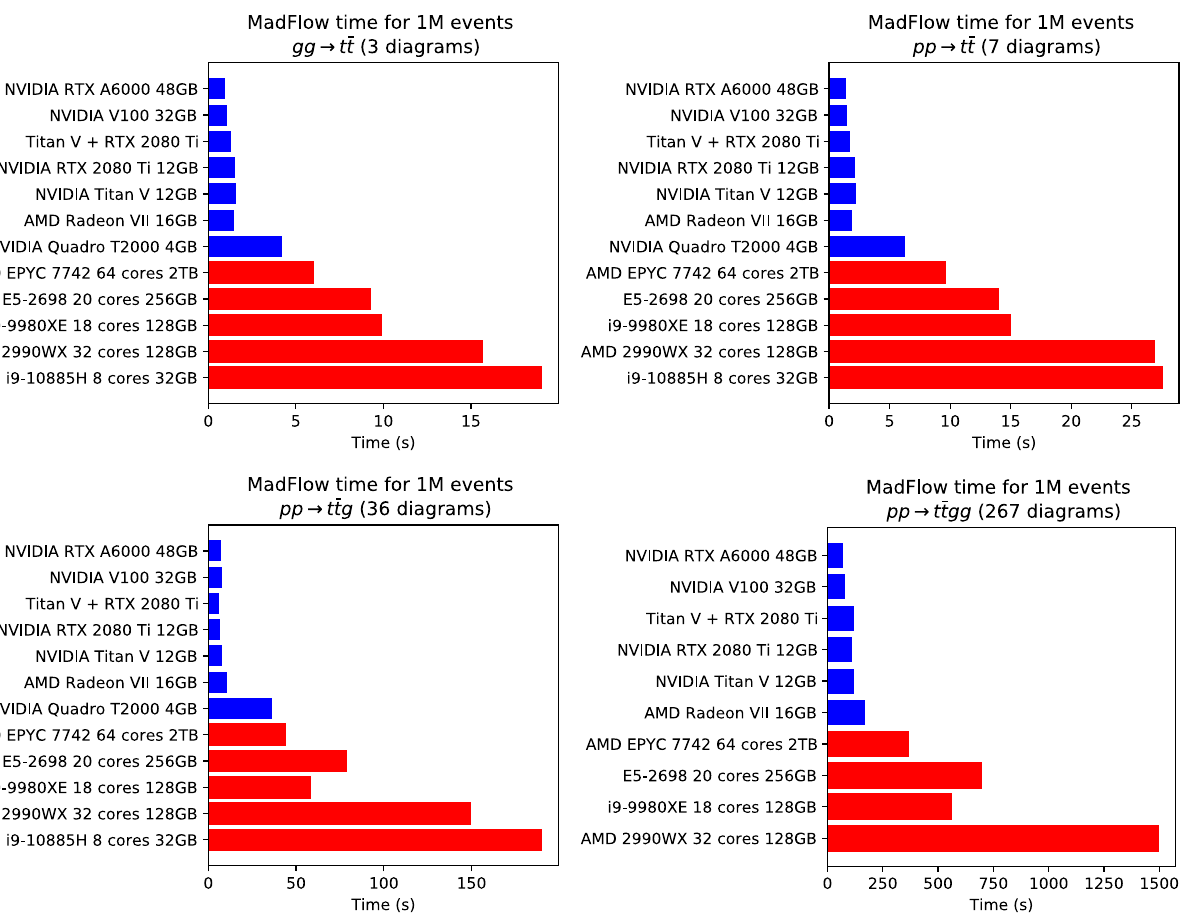
Fig. 3 Timings obtained with MadFlow to evaluate events at Leading Order for gg → t ¯ t (top left), pp → t ¯ t (top right), pp → t ¯ tg (bottom left) and pp → t ¯ tgg (bottom right). We show results for consumer